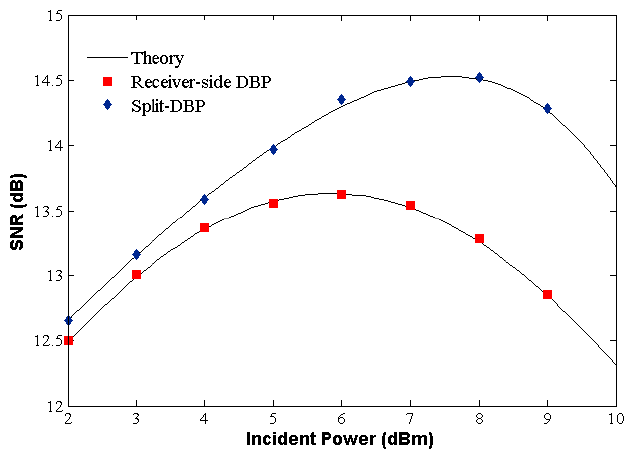
Figure 5. SNR vs. incident power.